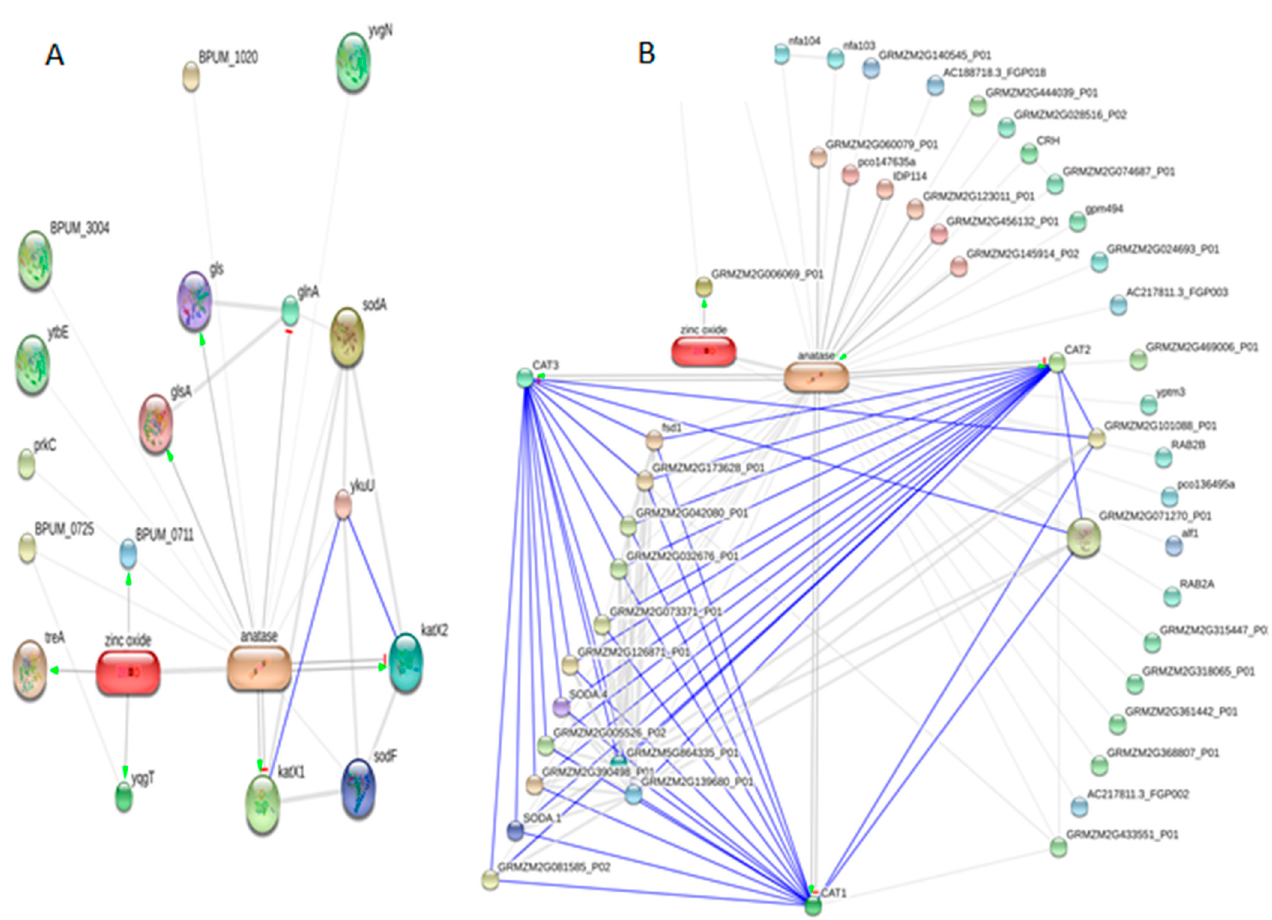
Figure 4. ZnO–TiO 2 protein interaction pathway in Bacillus pumilus ( A ) ZnO–TiO 2 protein interaction pathway in Zea mays ( B ).